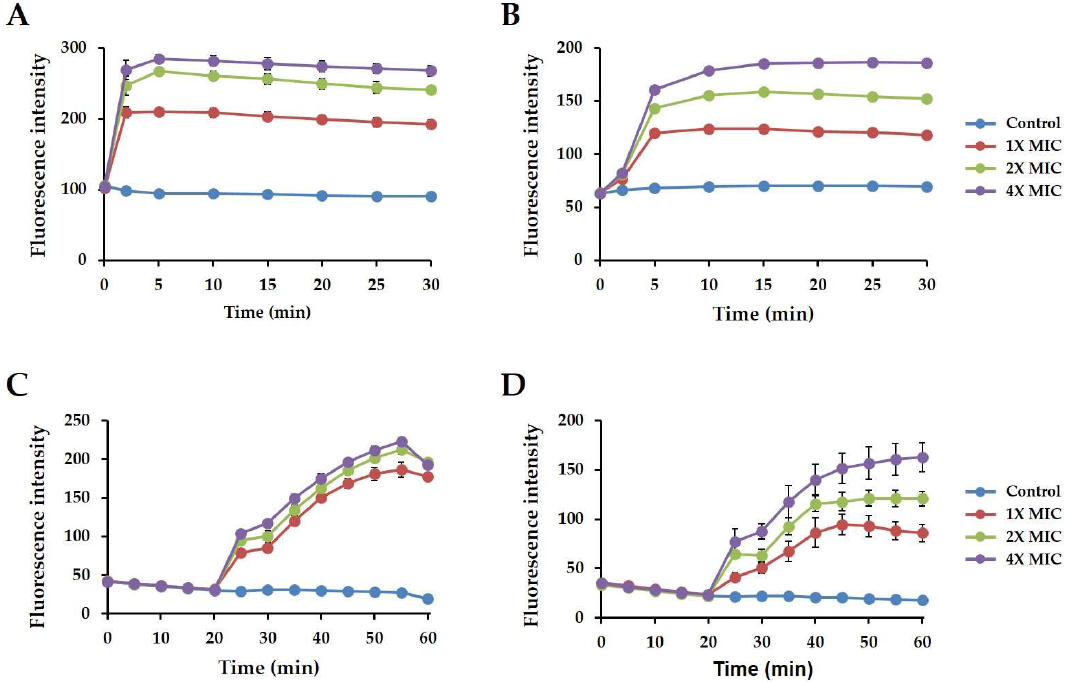
Figure 7. Magainin 2 mechanism of action. ( A , B ) The outer membrane permeability of magainin 2 2 was measured using NPN was measured using NPN dye. ( C , D ) Depolarization of cytoplasmic membrane induced by magainin 2, determined using the membrane potential-sensitive fluorescent dye DisC 3 -5. ( A , C : Acinetobacter baumannii KCTC 2508, B , D : Acinetobacter baumannii 907233).